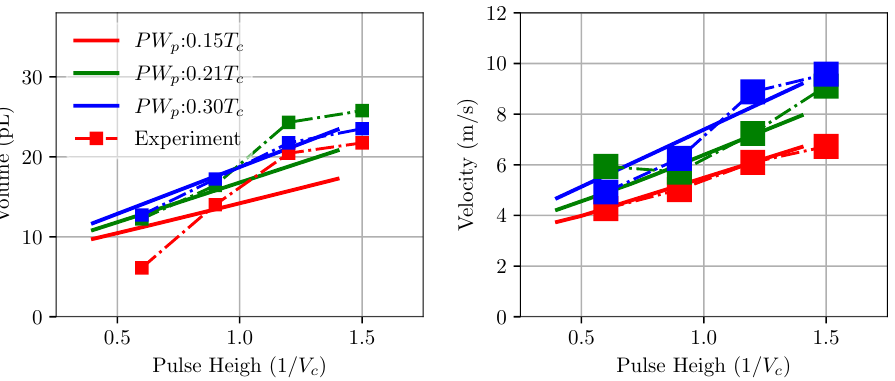
Figure 16. Behaviour of droplet volume and velocity with changes in pulse height (voltage) for the RC1536 channel obtained from experiment and model. The model prediction is in good agreement with the experiment